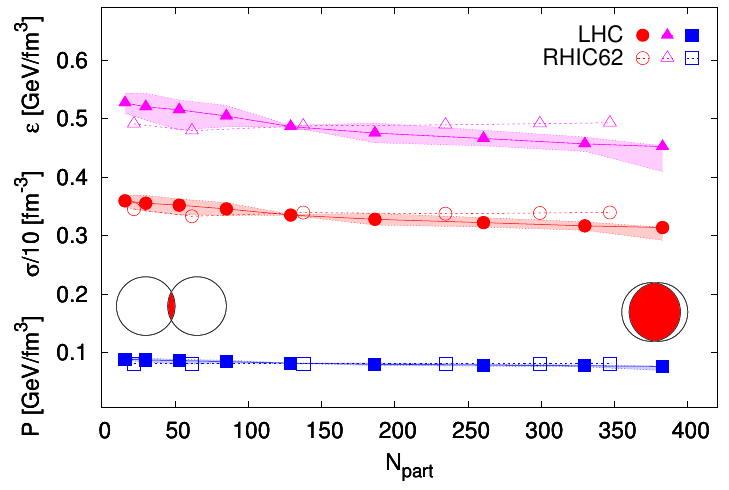
Figure 2. Bulk properties of the hadronizing fireball obtained at LHC-2760 and compared to RHIC-62 as a function N part . From top to bottom: energy density ε , entropy density σ (scaled down by factor 10), pressure P